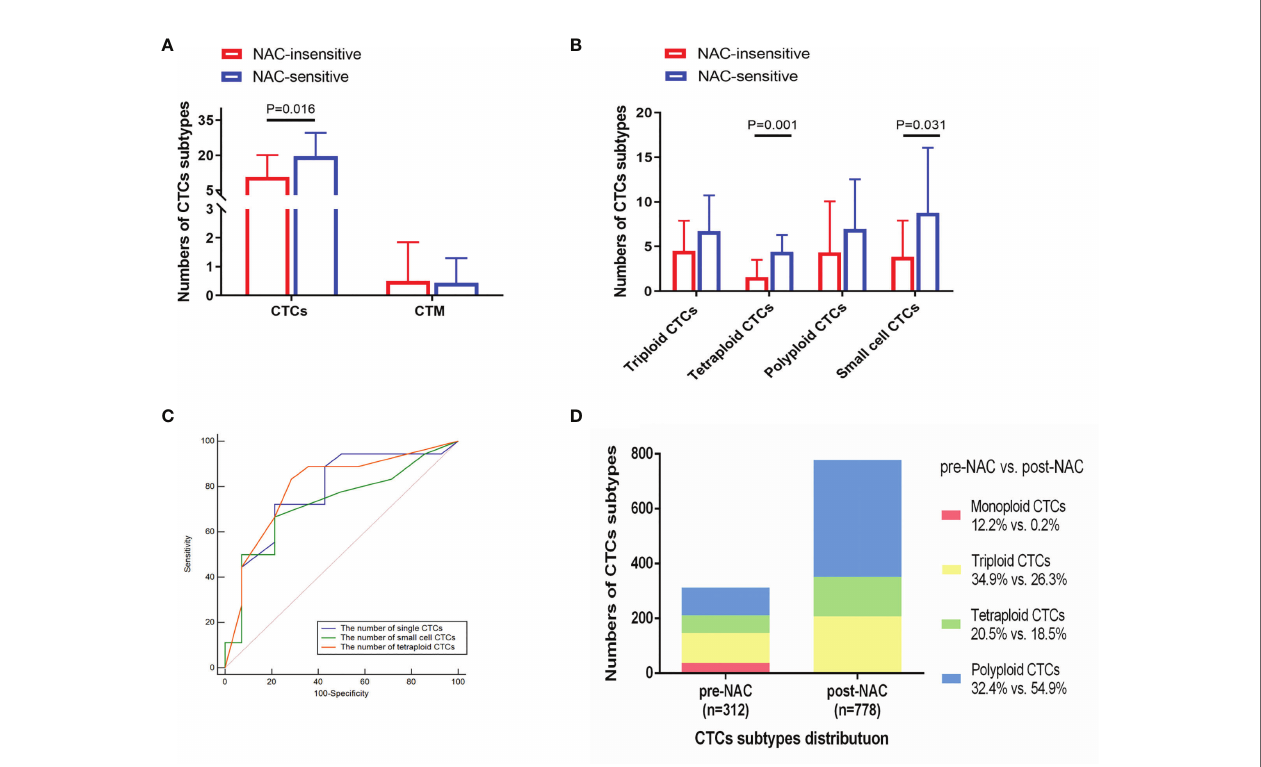
FIGURE 3 | Analysis of CTC subtypes in correlation with NAC sensitivity in 32 bladder-cancer patients. (A, B) NAC-sensitive patients had an increasing quantity of pre-NAC CTCs, tetraploid CTCs, and small cell CTCs compared with NAC-insensitive patients. (C) Receiver operator characteristic (ROC) curves analysis showed that pre-NAC CTCs, tetraploid CTCs, and small cell CTCs could differentiate NAC-sensitive patients (n = 18) from NAC-insensitive ones (n = 14). (D) Distribution of CTC subtypes before and after